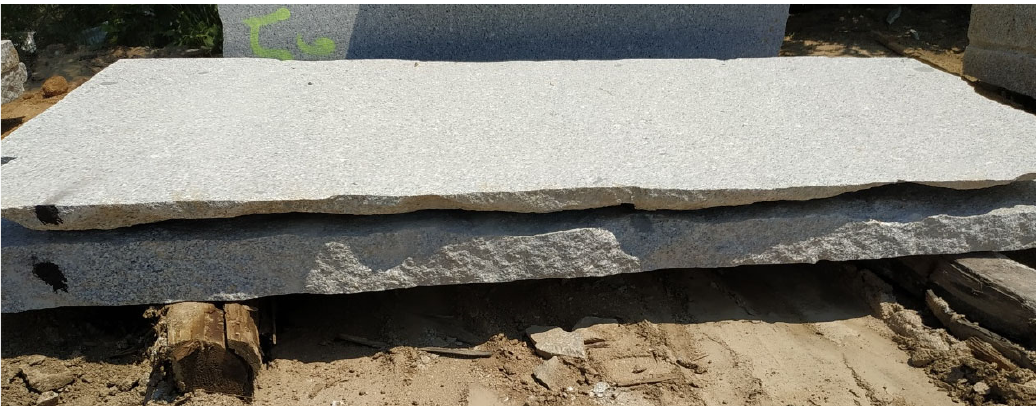
Figure 3. Offcuts (2.5 m long, 1.5 m wide, 0–0.1 m thick).